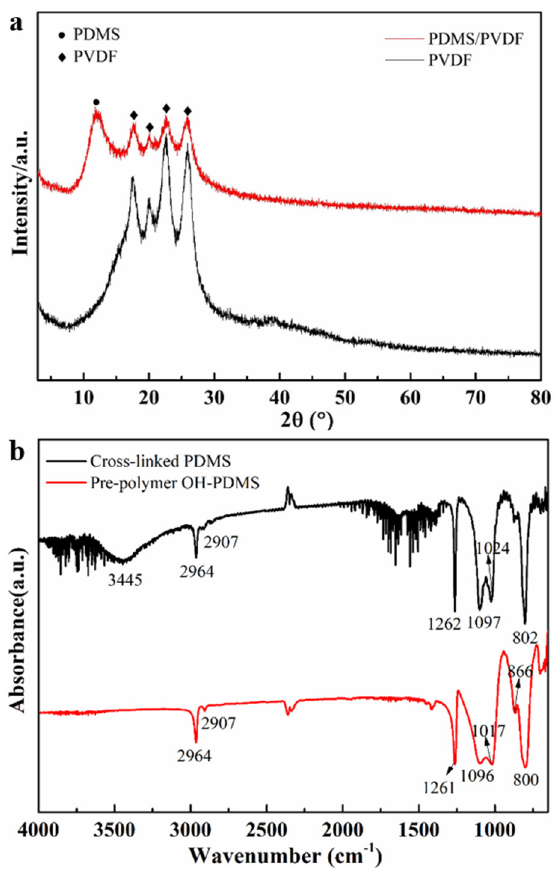
Figure 4. XRD patterns and FTIR spectrums of the PDMS membranes: XRD patterns ( a ); FTIR spectrums ( b ).